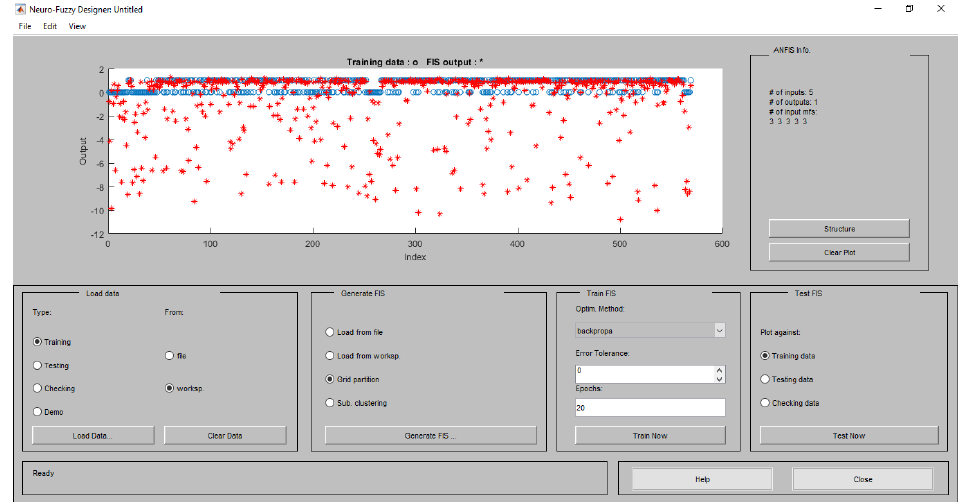
Figure 13. Trend of trained dataset.